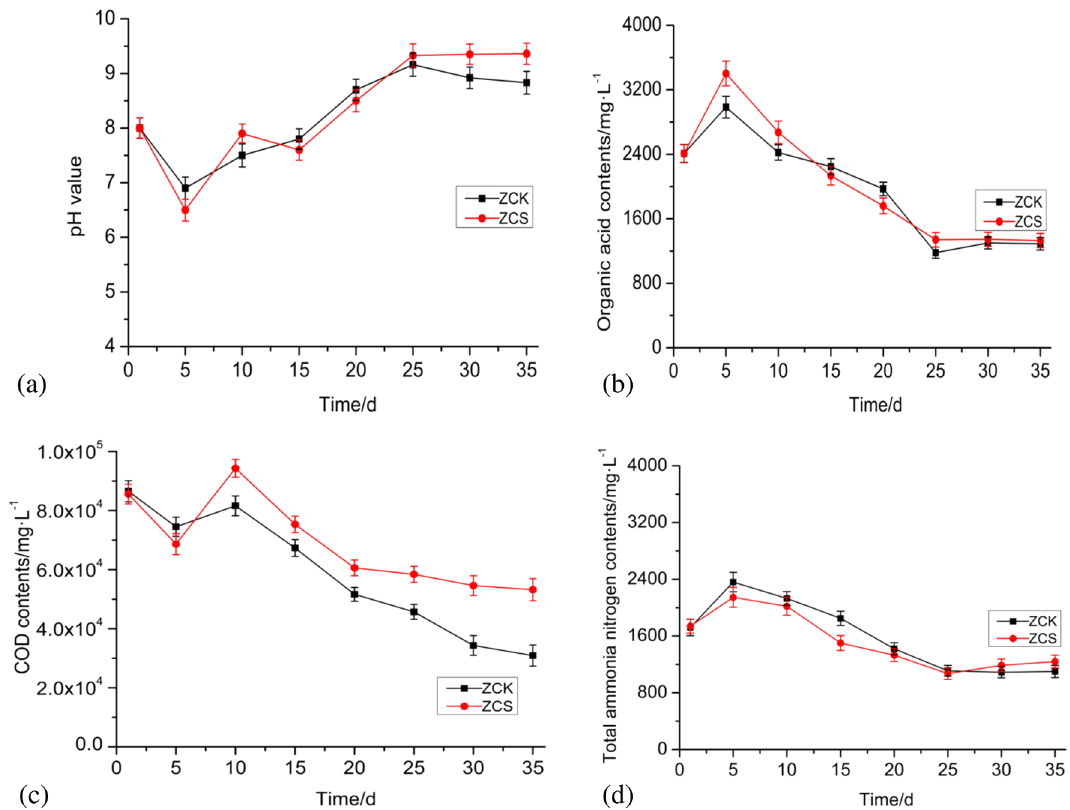
Figure 2. Changes in related physical and chemical indices of the anaerobic digestion system. ( a ) pH; ( b ) organic acid concentration; ( c ) COD concentration; ( d ) ammonia–nitrogen